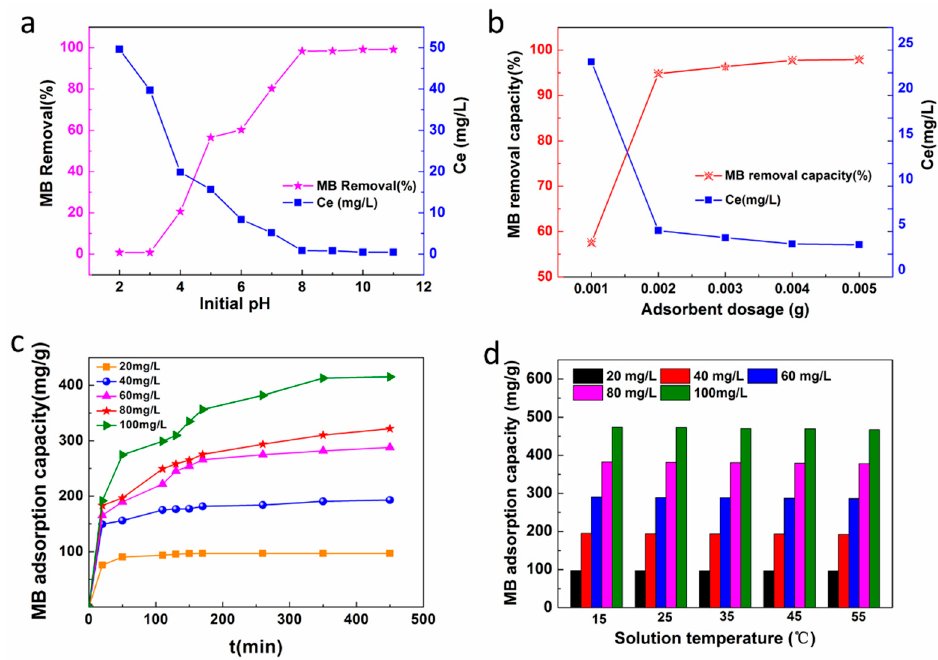
Figure 6. ( a ) Effects of solution pH on MB removal, ( b ) effects of adsorbent dosages on MB removal, ( c ) effects of contact time and initial MB solution concentration on MB adsorption, ( d ) effects of solution temperature on MB removal at different initial MB concentrations.